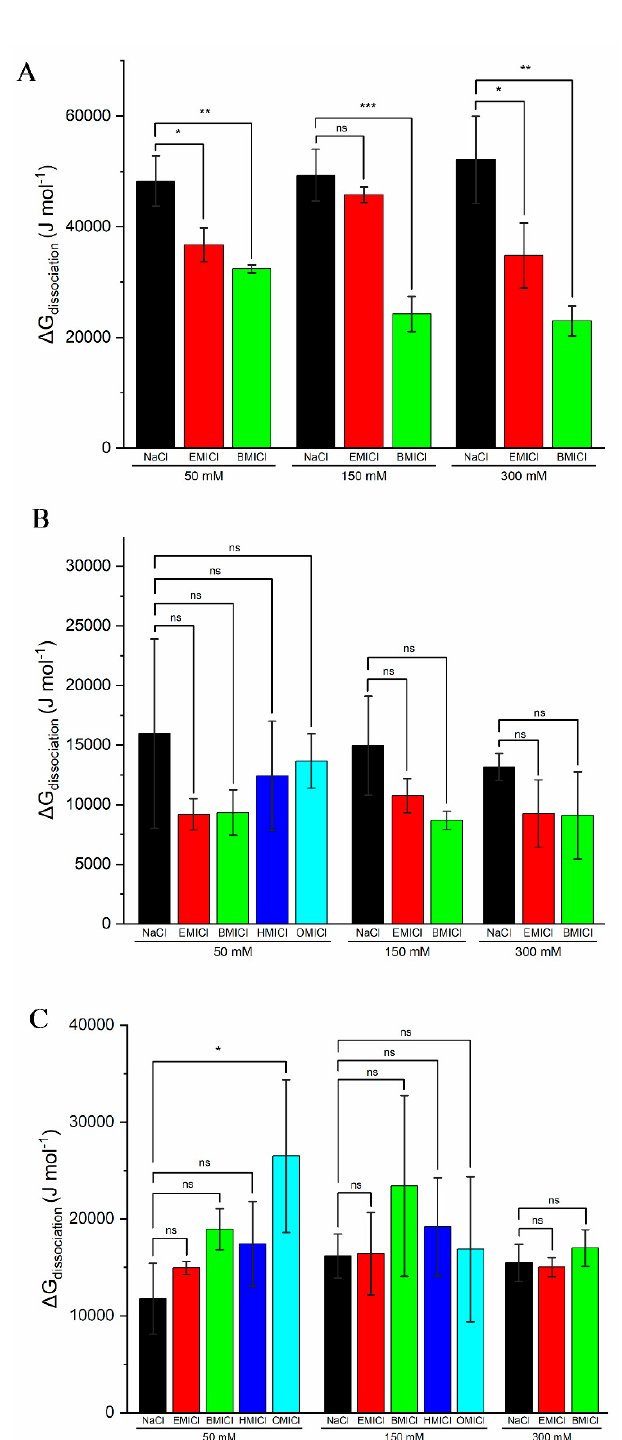
Figure 6. Thermodynamic values and statistical analysis for Δ G dissociation for heme by ( A ) SDS, ( B ) EBB, or ( C ) TTAB. Δ G dissociation values are calculated as the average of individual replicates with error bars representing standard deviation of the values calculated from each trial. Statistical analysis was performed by SAS Institute’s JMP Pro 13 (Cary, NC, USA) with ns = no significant difference, * P ≤ 0.05, ** P ≤ 0.01, and *** P ≤ 0.001.